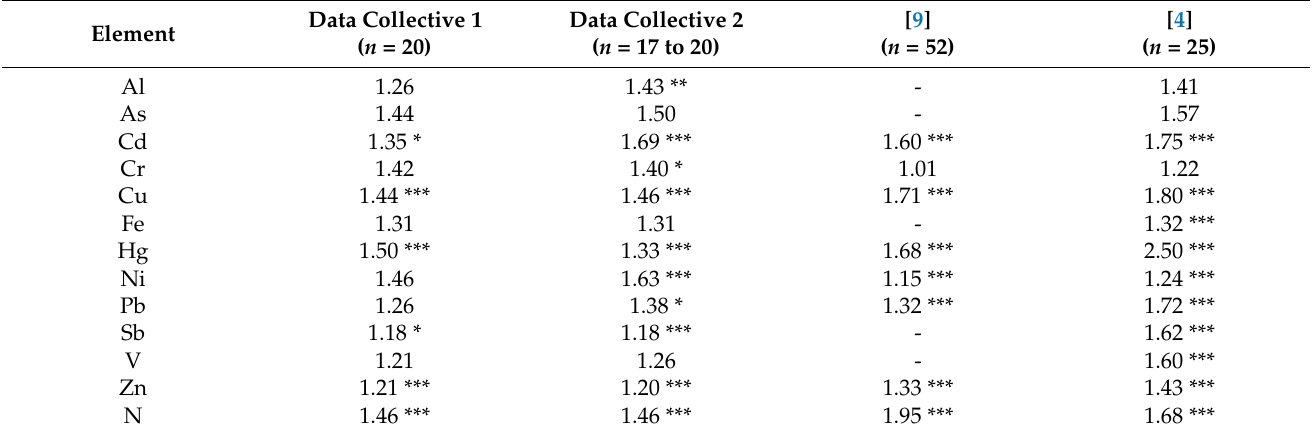
Table 2. Comparison of the determined median value ratios between open land and canopy drip plots in northwest Germany 2021 with values from